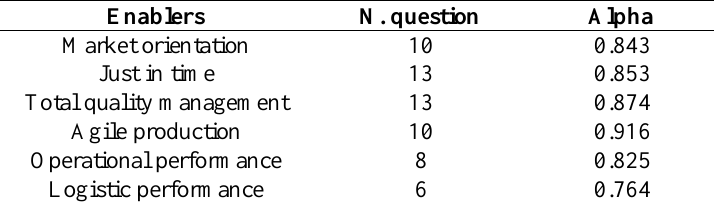
Table 1. Cranach alpha